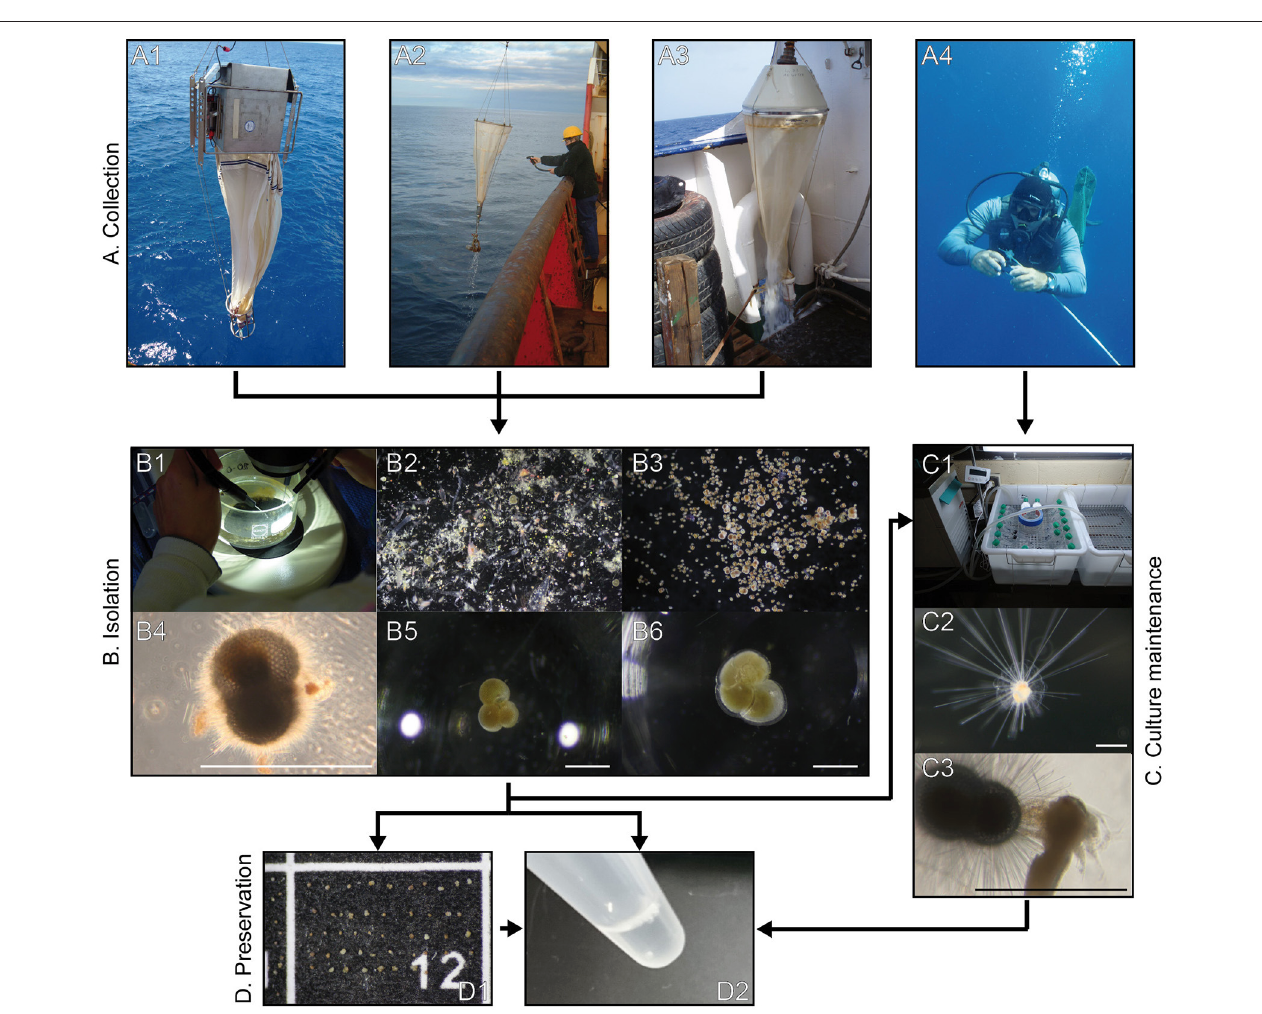
FIGURE 2 | Photographs of the methodological pathway for sampling, isolation, preservation and culture maintenance of planktonic foraminifera. The linkage between the different methods is represented by connecting arrows. Section A shows the four different ways of collecting planktonic foraminifera: multiple-closing net (A1) , simple plankton net (A2) , seawater pump (A3) and scuba diving (A4) . Section B depicts the isolation of specimens from the bulk plankton sample (B1–3) by showing them in various stages of cleaning with and without attached contaminants (B4–6) . Photographs of section C show the culture maintenance of planktonic foraminifera: culture vials in water baths with flow-through system (C1) , living individual of Hastigerina pelagica (C2) , individual of Trilobatus sacculifer feeding on an Artemia salina nauplius (C3) . Section D represents the preservation methods “drying and freezing” (D1) and “direct storage in buffer” (D2) . Scale bars measure 500 µ